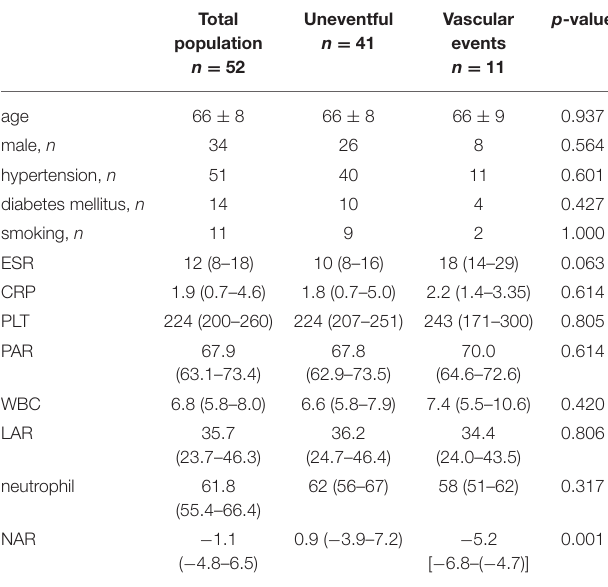
TABLE 1 | Demography and clinical data of the total population, and comparison between patients without vs. with recurrent vascular events during 36-month follow-up.